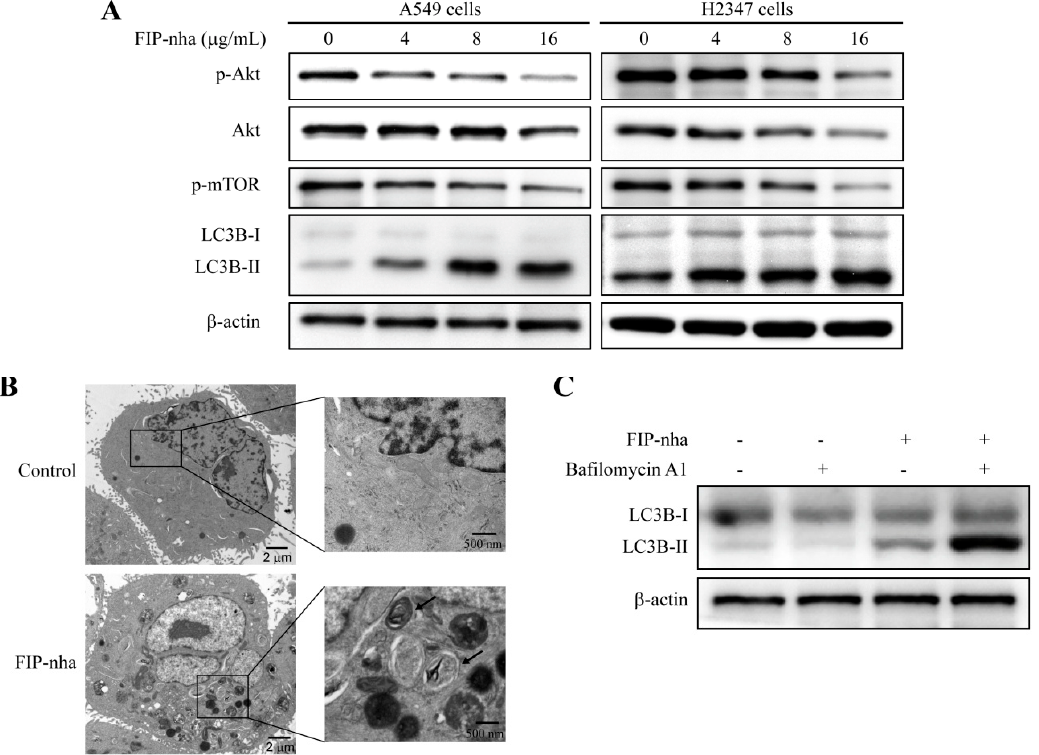
Figure 3. FIP-nha negatively regulates the PI3K/Akt signaling pathway and induces autophagy in lung adenocarcinoma cells by downregulating p-mTOR. ( A ) A549 and H2347 cells were treated with 0, 4, 8, and 16 µ g/mL FIP-nha for 24 h. The protein expression levels of p-AKT, AKT, p-mTOR, and LC3B-I/II were examined by western blotting. ( B ) Ultrastructures of autophagosome in A549 cells treated FIP-nha (8 µ g/mL) for 24 h. Arrows indicate autophagosome vesicles contained double membranes and damaged organelles. ( C ) A549 cells were treated with FIP-nha (8 µ g/mL) for 24 h and then bafilomycin A1 (50 nM) for another 4 h. The protein levels of LC3B-I/II were examined by western blotting.